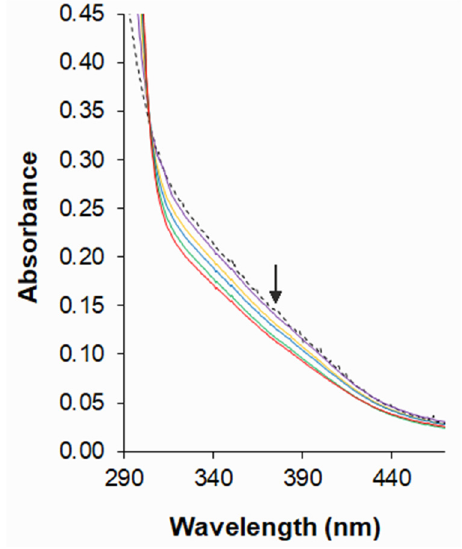
Figure 4. Electronic absorption spectra of species in Co(II)–PicHA–AlaSal system ( C Co(II) = 6.5 × 10 − 5 M, at PicHA:AlaSal:Co(II) molar ratio 2:2:1) in 5 mM Tris-HCl/NaCl buffer with increasing concentration of CT-DNA (2.50 × 10 − 4 –1.88 × 10 − 3 M) at pH 7.2. Dashed line corresponds to the Co(II)–